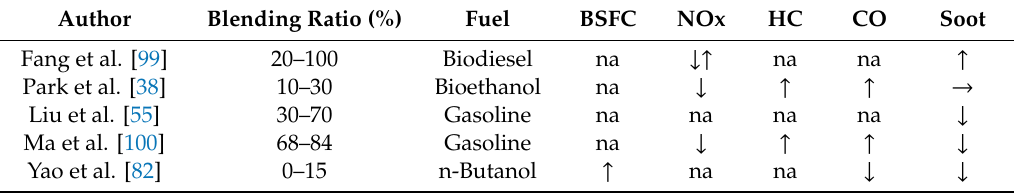
Table 8. Variation of performance and emissions after increasing the blending ratio of alternative